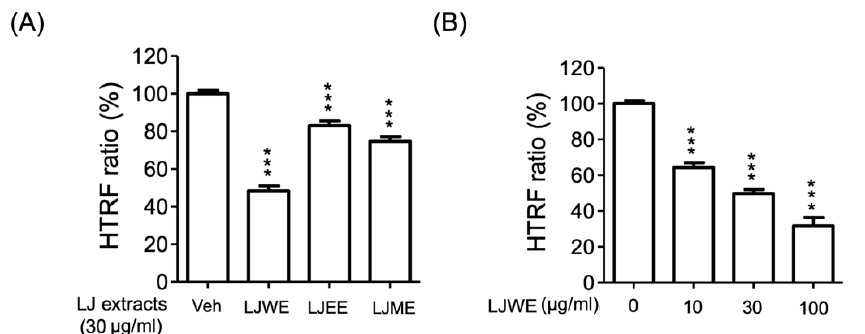
Figure 7. Lonicerae japonicae flos (LJ) extracts interrupted the binding of severe acute respiratory syndrome coronavirus 2 spike protein (SARS-CoV-2 spike)/angiotensin-converting enzyme 2